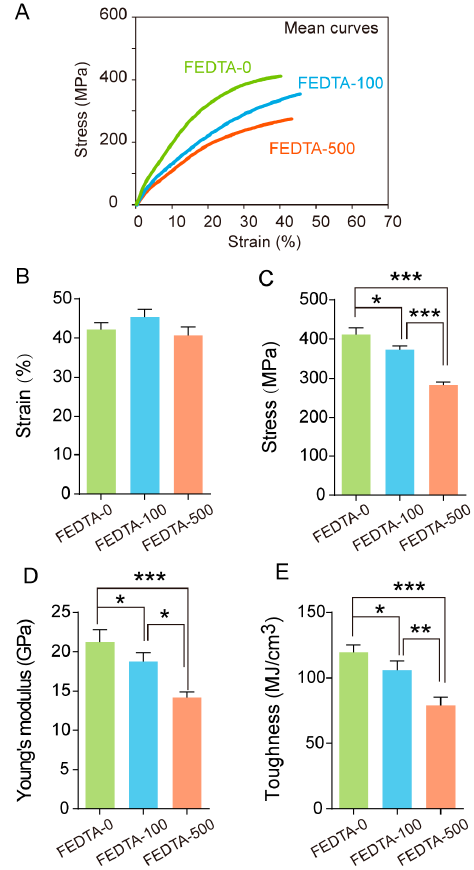
Figure 7. Effect of metal ions on the mechanical properties after feeding. ( A ) Average stress-strain curves of each injected group; ( B ) Maximum strain; ( C ) Maximum stress; ( D ) Young’s modulus; ( E ) Toughness. Error bars, SD; *, p < 0.05, **, p < 0.01, ***, p < 0.001 (One-way ANOVA).